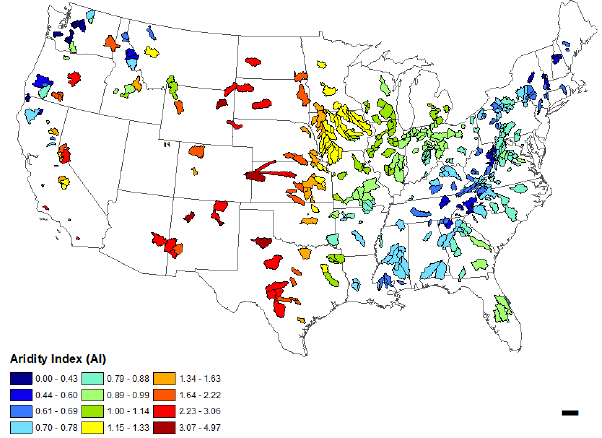
Fig. 2. Spatial distribution of the aridity index ( E p /P